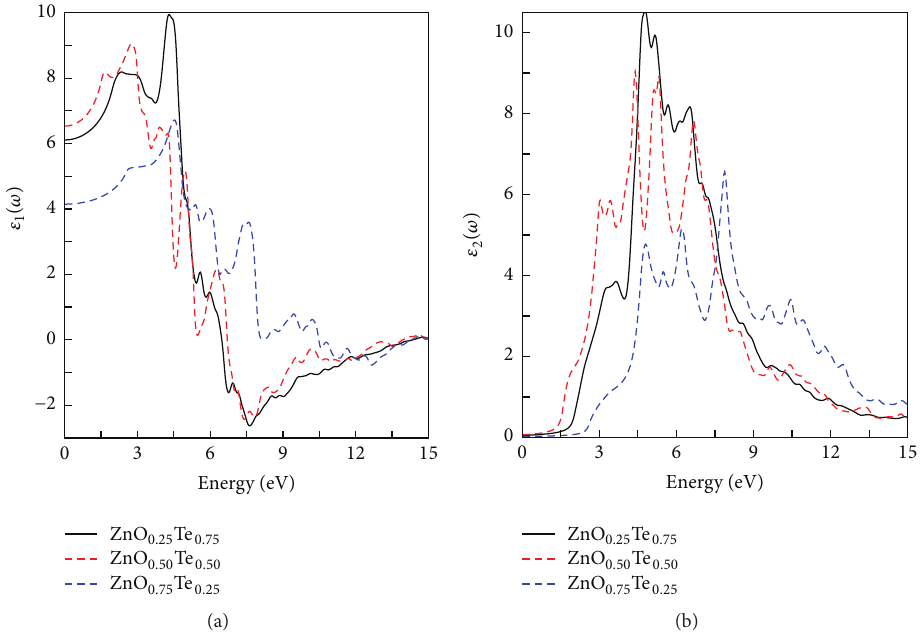
Figure 4: Frequency dependent (a) real and (b) imaginary part of dielectric